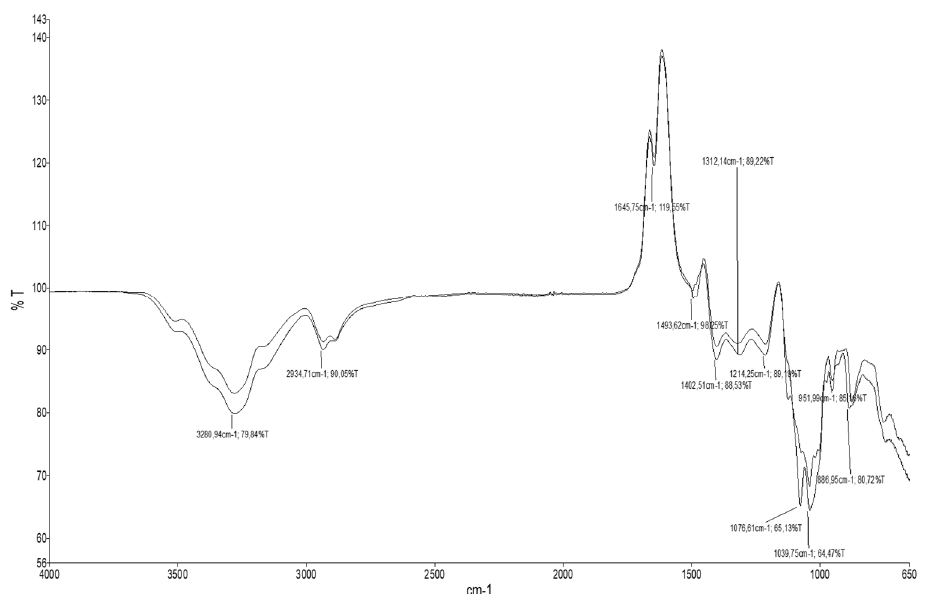
Figure 1. FTIR spectrum of natural deep solvent prepared from choline chloride and glycerol (CHGLY).